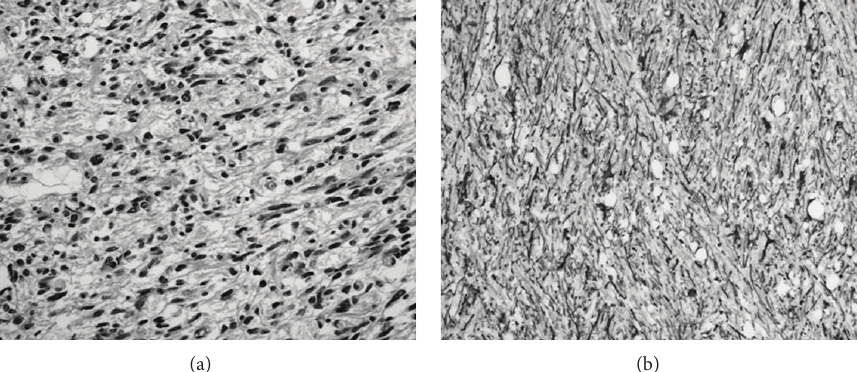
Figure 4: (a) Brain tissue. Diffuse infiltration of the white matter by neoplastic cells having elongate nuclei and fibrillary cytoplasm. The neuropile shows a finely fibrillary pattern (H&E, × 20). (b) Brain tissue. The neoplastic cells show a diffuse marked immunoreaction for glial fibrillary acidic protein. They are characterized by long branched cytoplasmic processes (antiglial fibrillary acidic protein-immunolabeling, ×